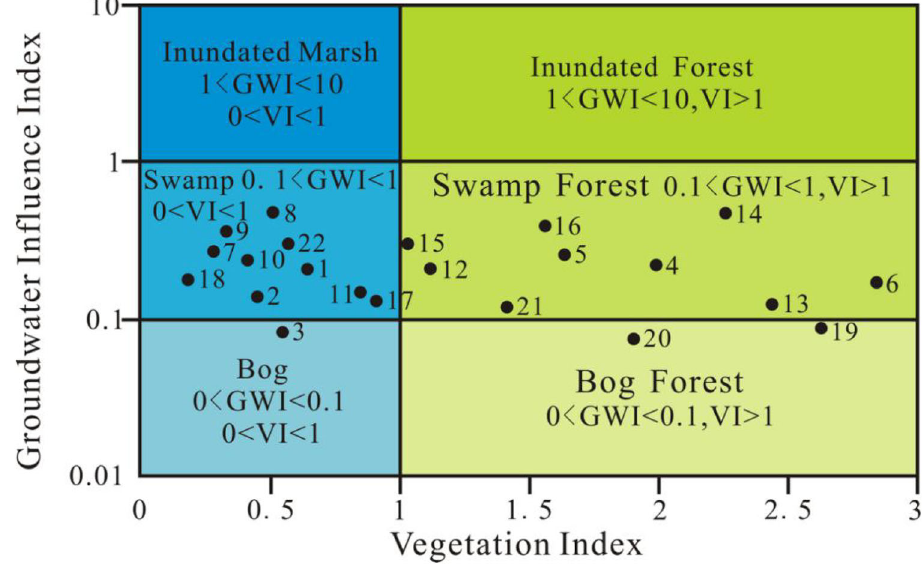
Fig. 6 Coal-forming swamp interpretation based on GWI and VI in Hanshuiquan district, Santanghu Coalfield, NW China. Modified by Calder et al.